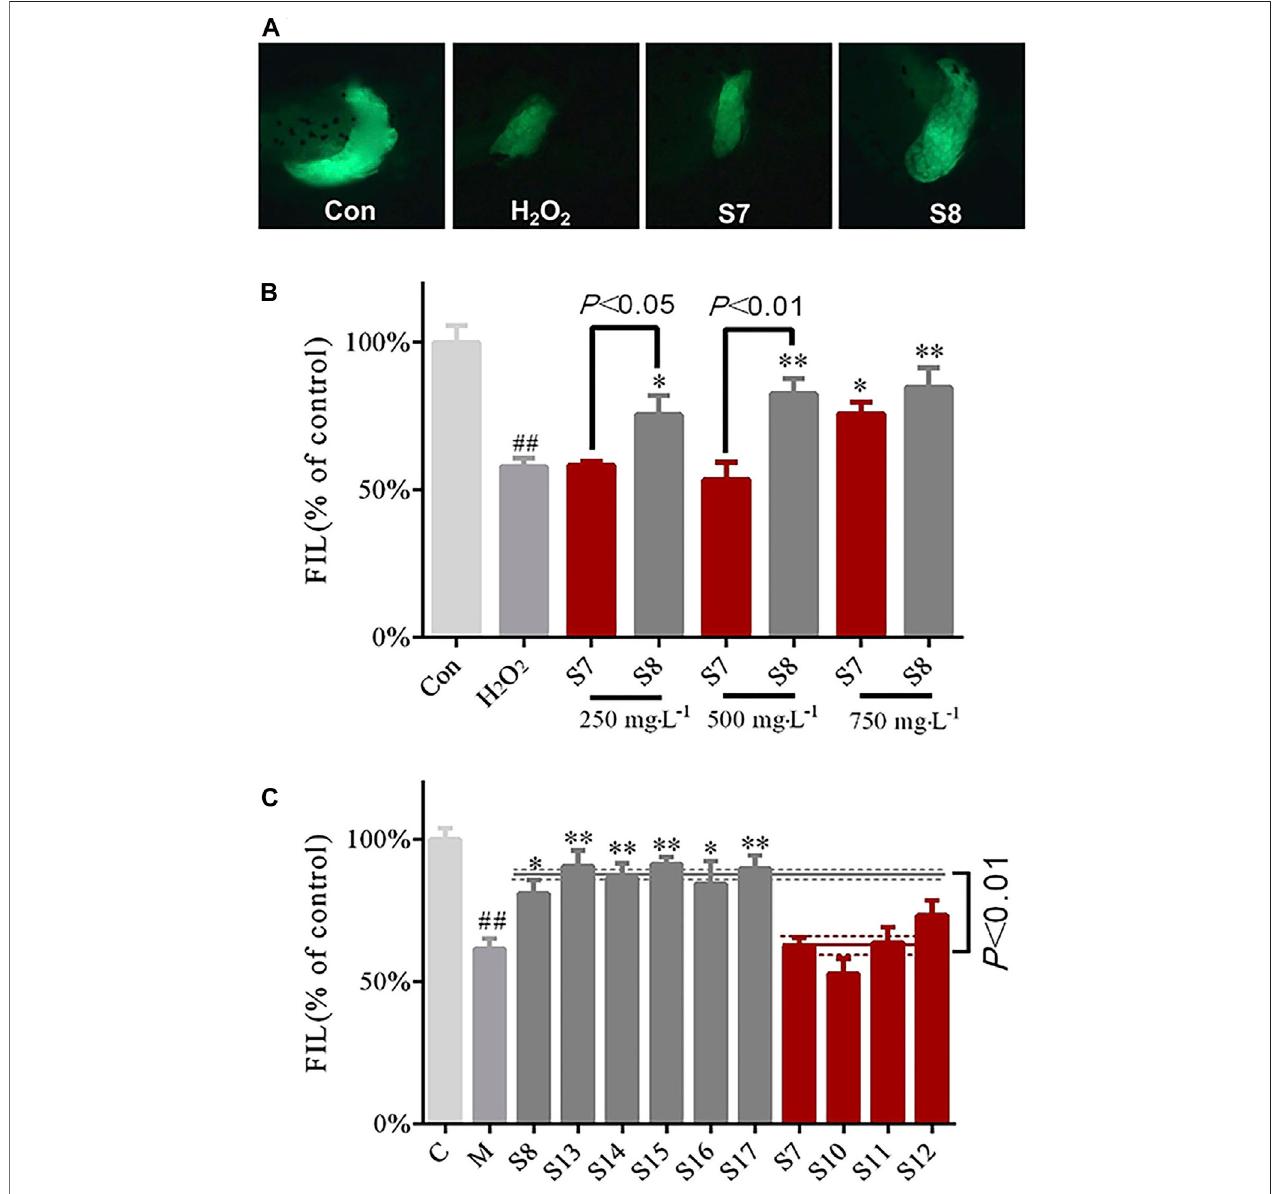
FIGURE 2 | Comparison of the protective effects of GF (S7 and S8) collected from speci fi c locations on liver injury (A) Phenotypic micrograph of the transgenic zebra fi sh with fl uorescence label in the liver (B) Comparative analysis of protective effects of S7 and S8 with different doses on liver injury (C) Comparison of multiple batches of protective effects of GF from two areas, Fuding and Jiujiang, on the liver. n (cid:2) 10.